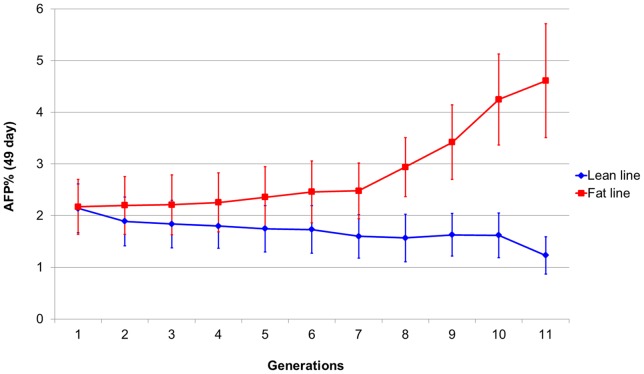
Phenotypic changes after 11 generations of divergent selection for high and low abdominal fat content.